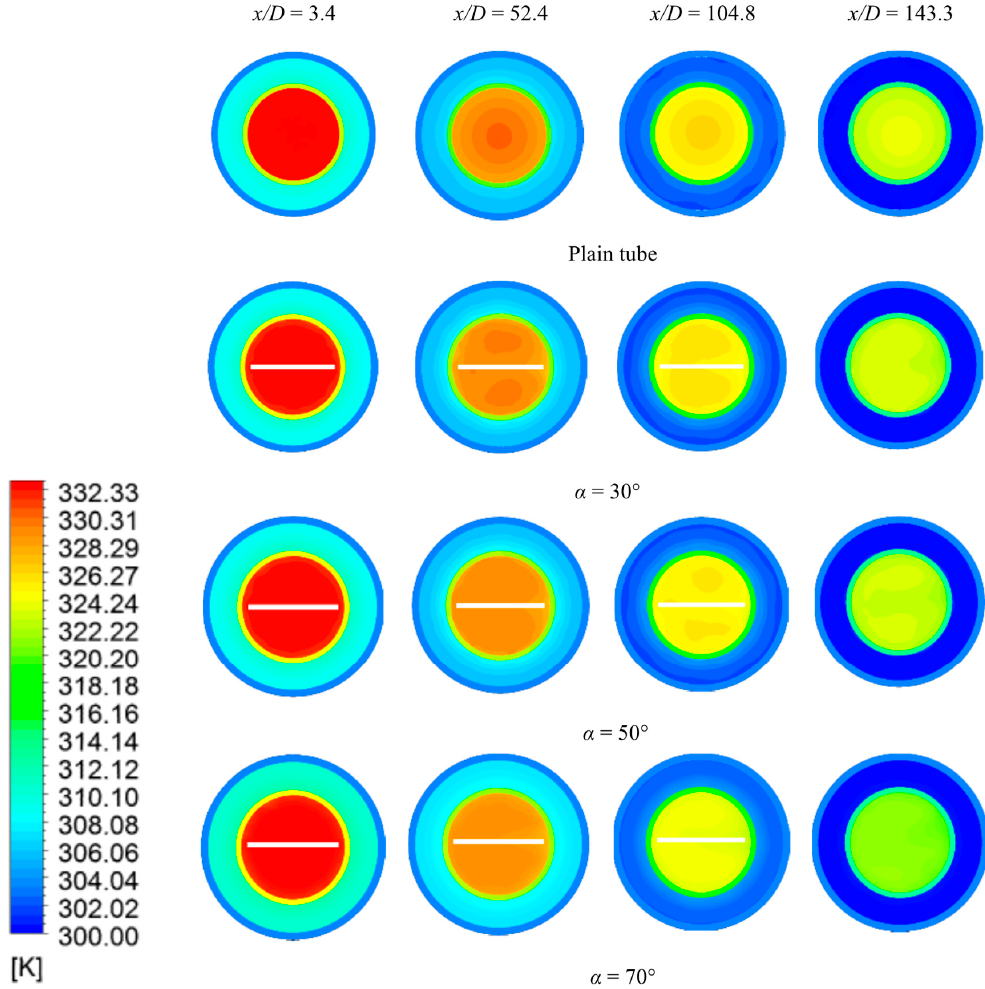
Figure 6. Local inner tube temperature contour at Re = 17,400.